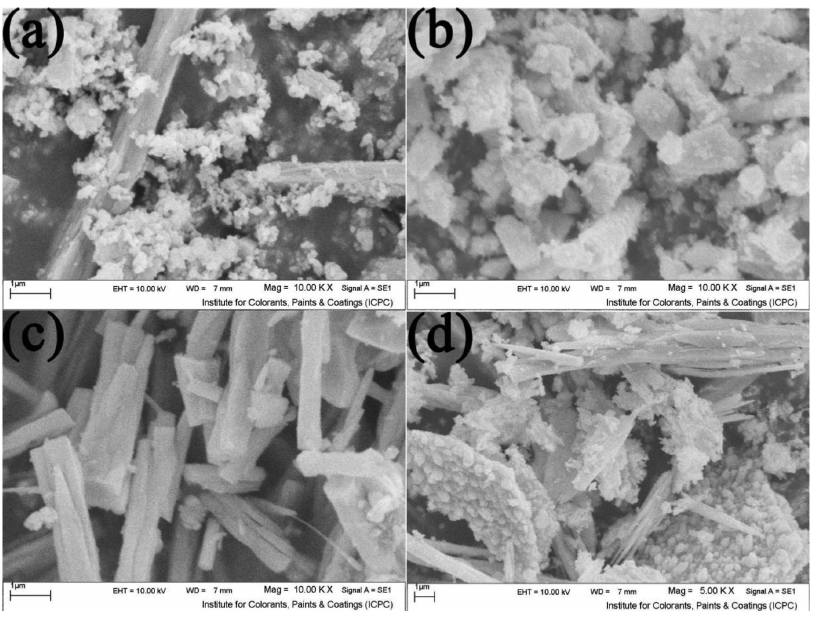
Figure 5: SEM image of (a – d) sample no. 7 – 10,